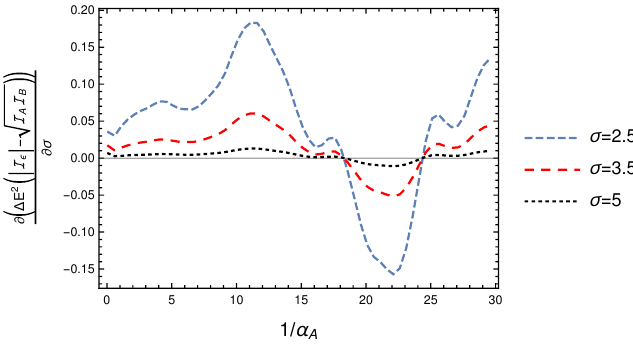
Figure 13 . In (1 + 3) dimensions the derivative with respect to σ of the quantity √ (cid:1) is plotted for two anti-parallelly accelerating detectors for varying ∆ E 2 (cid:0) |I I A I B ε | − other parameters α = 1 and α are fixed. B A